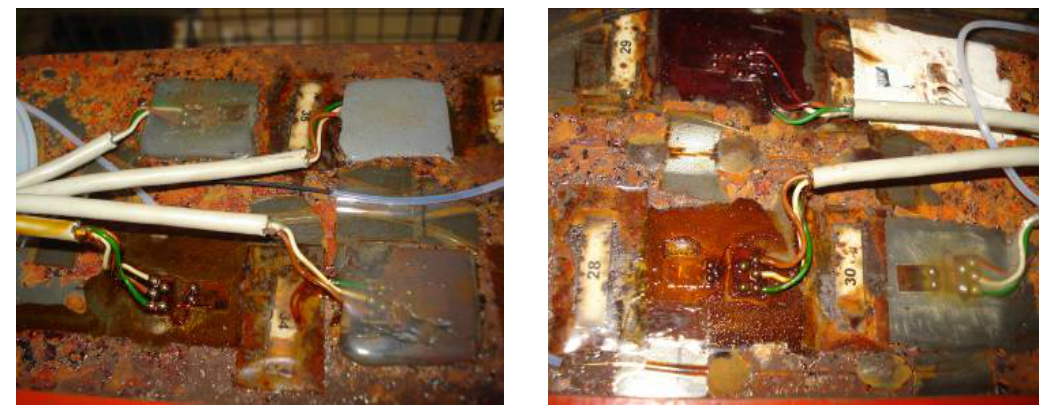
Figure 5 . State of the gauges and FBGs after aging on climate